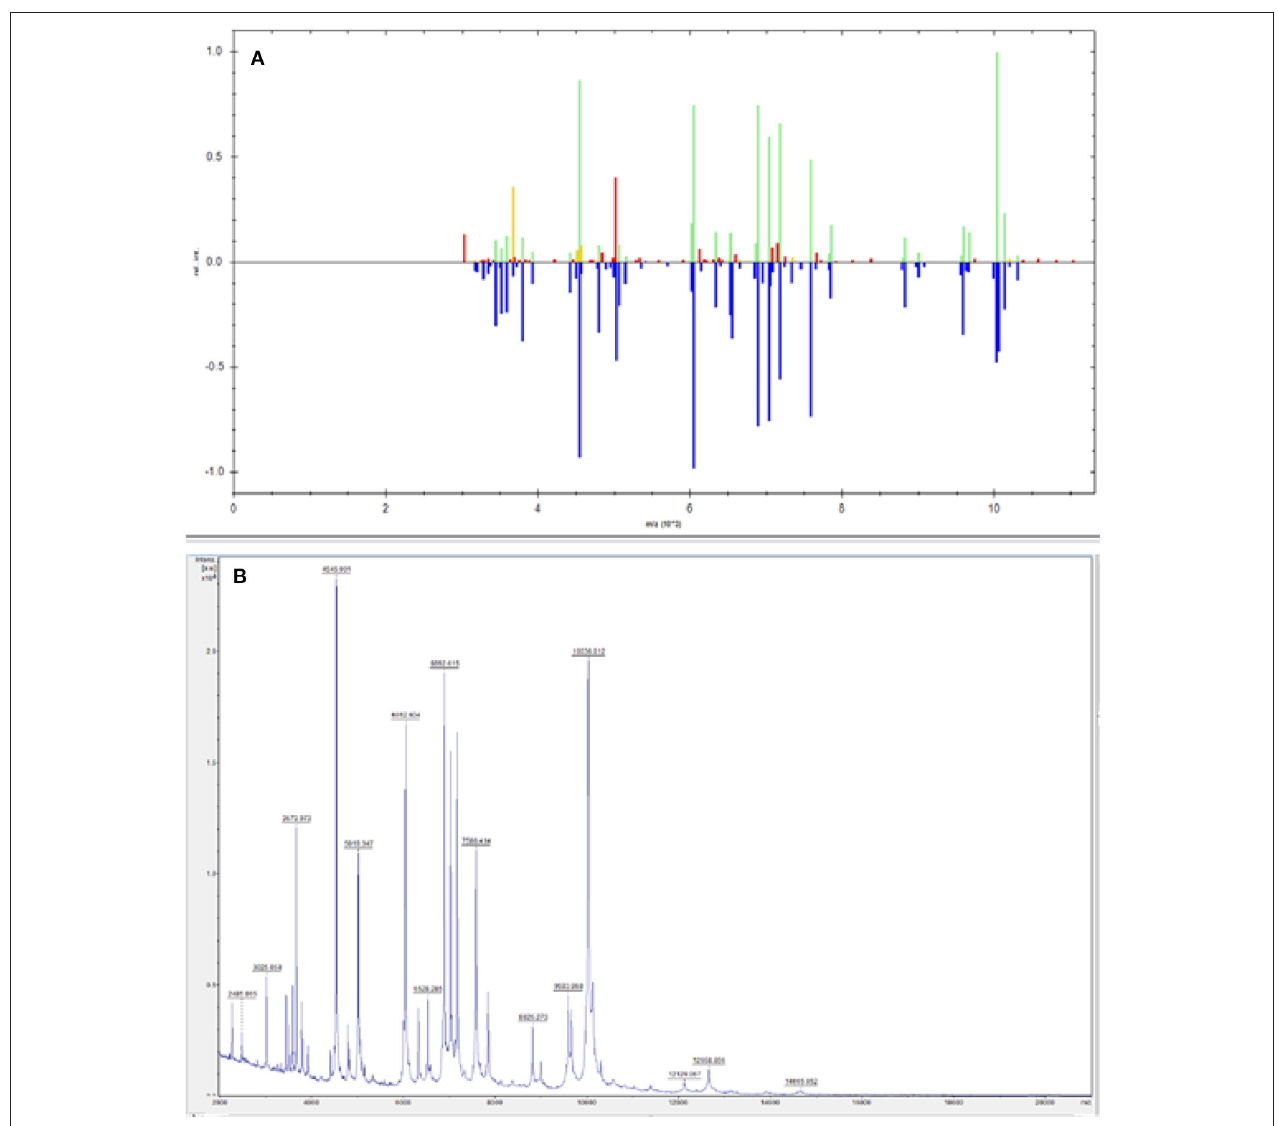
FIGURE 3 | The 16s sequencing comparison result of blood culture samples from patients was Elizabethkingia, and the final sequencing result was Elizabethkingia miricola (A) . NCBI comparison of 16S sequencing results (B) . Primer: 27F AGTTTGATCMTGGCTCAG; Reverse: 1492R GGTTACCTTGTTACGACTT. The 16S amplified sequence of the sample was 100% compared with that of Elizabethkingia miricola .